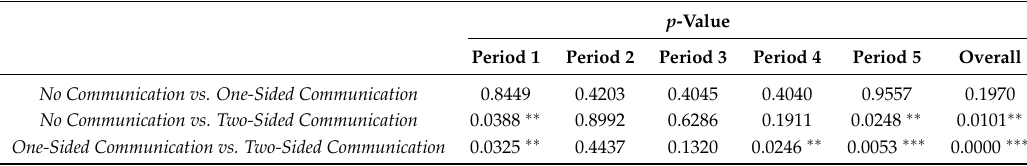
Table A2. Mann Whitney U tests: Comparisons of individual average offers across treatments.